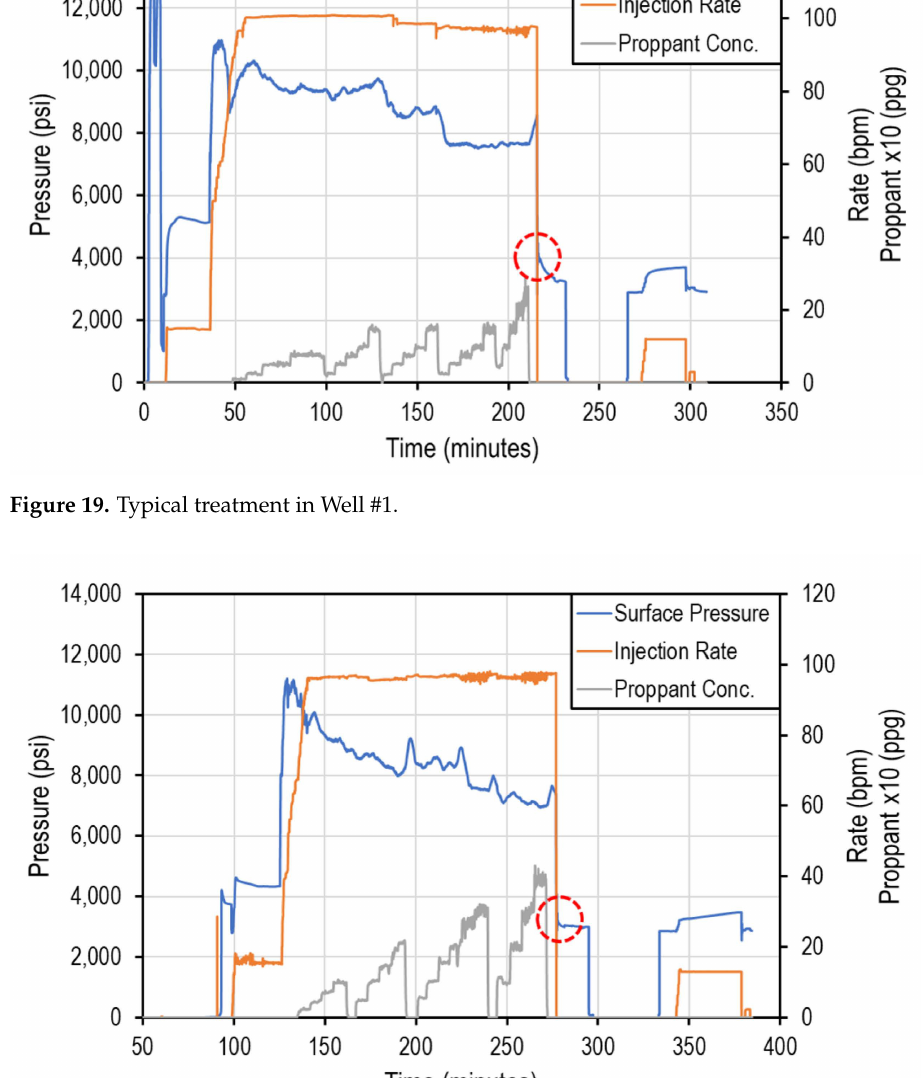
Figure 20. Typical treatment in Well